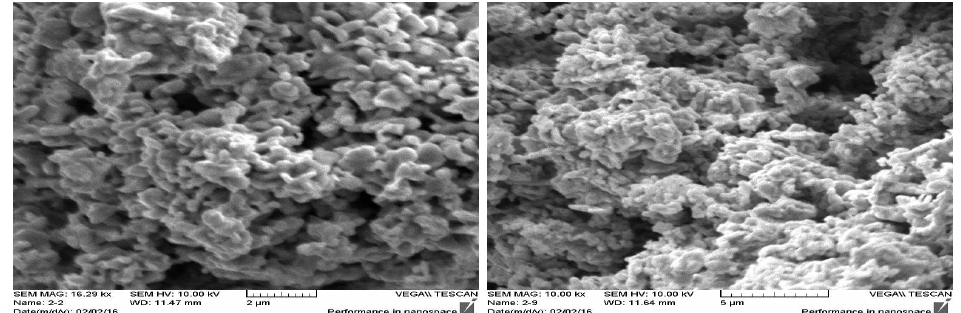
Fig. 4. SEM photographs of CuO nanoparticles prepared via Sol- Gel